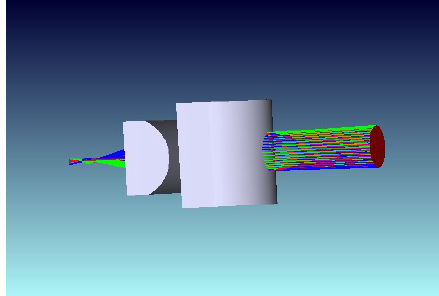
Figure 4. Simulated 3D model for alignment of laser emitting system